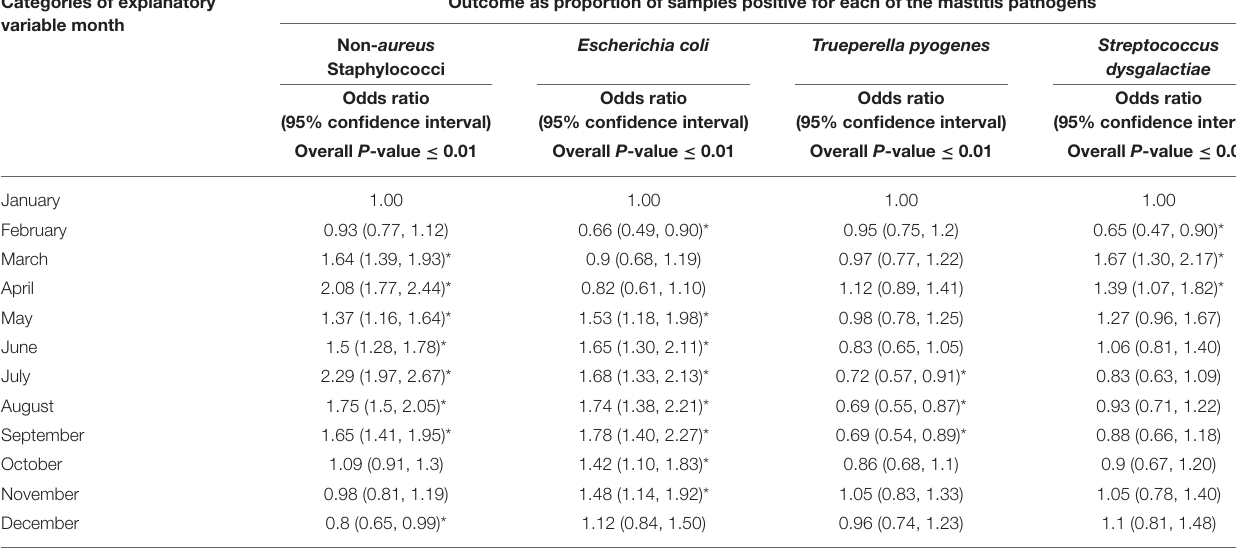
TABLE 7 | Regression analysis of the proportion of samples positive for environmental mastitis pathogens by month. Categories of explanatory variable month